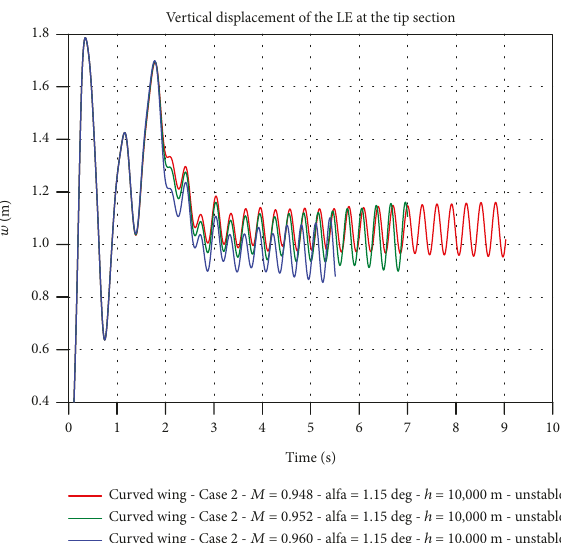
Figure 26: Damping vs. Mach (cruise: Case 2).